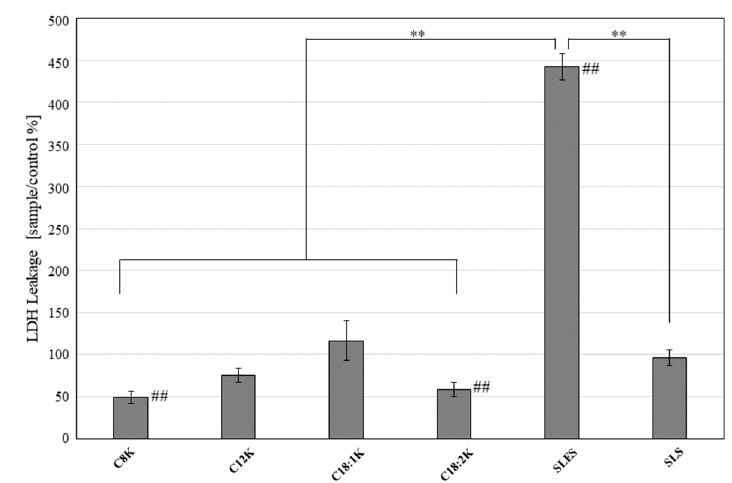
Figure 3. LDH leakage of NHEK-Ad cells treated with 0.5 mM fatty acid potassium, SLES, or SLS for 5 min. Untreated cells were used as the control. The percentage LDH leakage was calculated relative to the control value. Results are expressed as mean ± standard deviation (SD) values ( n = 8). ** p < 0.01; ## p < 0.01 compared to the control.